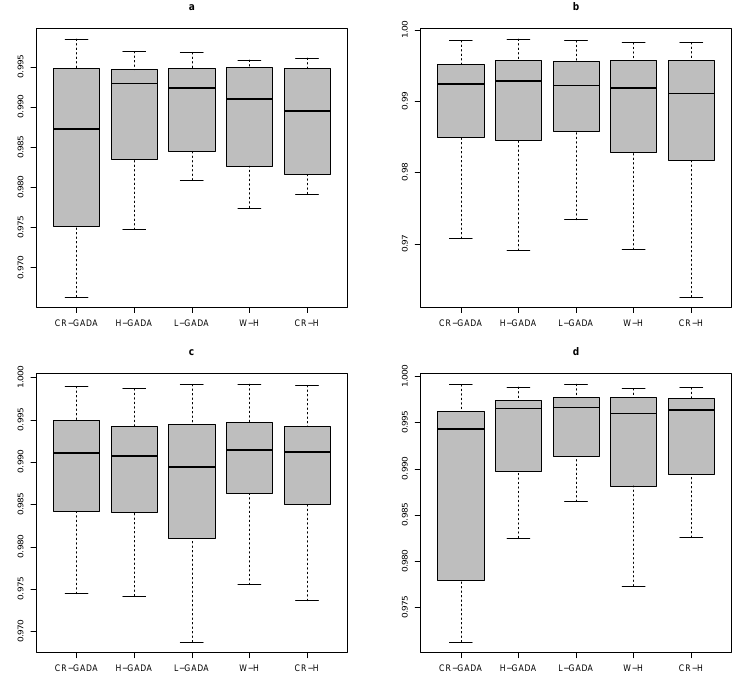
Figure 6. Boxplot (including the minimum score, first (lower) quartile, median, third (upper) quartile, and maximum score) of the coefficient of determination ( R 2 ) calculated for the species: ( a ) Pinus arizonica , ( b ) Pinus engelmannii , ( c ) Pinus strobiformis and ( d ) Pinus teocote , for the GADA and W-H models in comparison with the CR-H model proposed in the